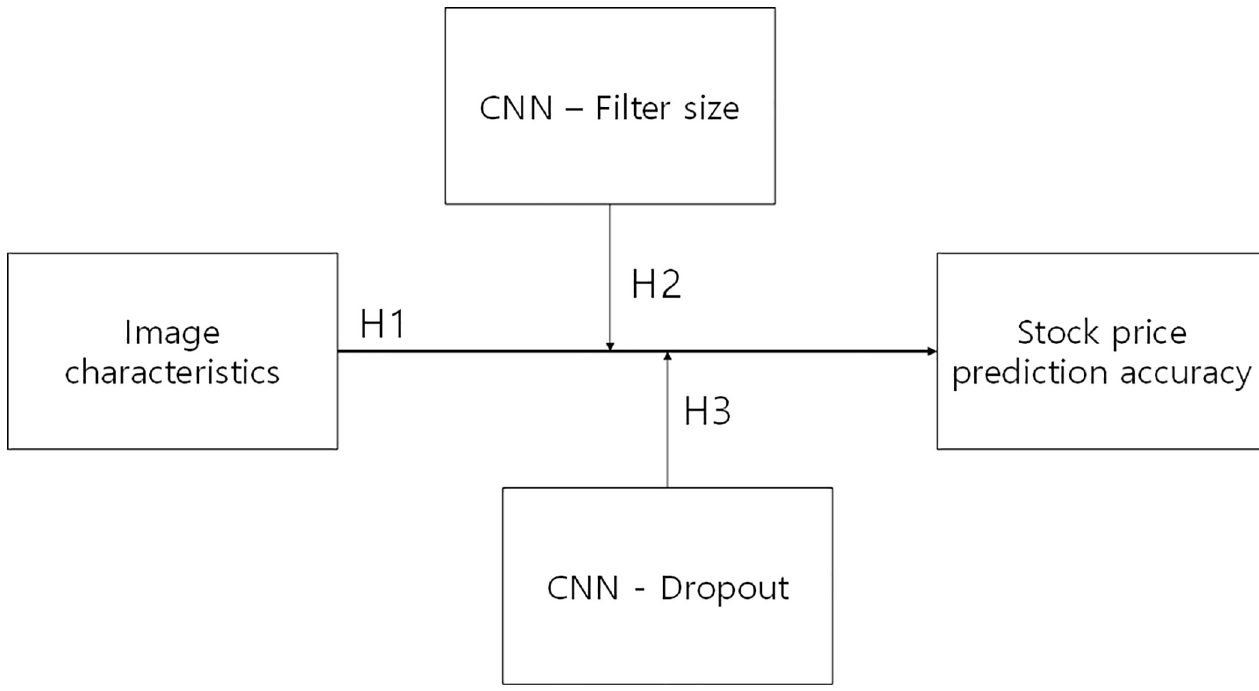
Fig 1. Research model.